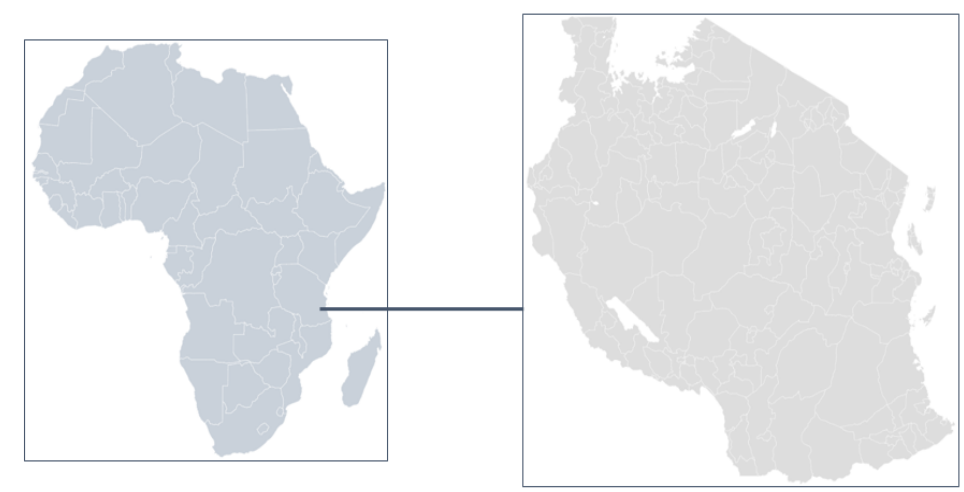
Figure 3. Maize cultivation calendar in Tanzania (Source: [22]).